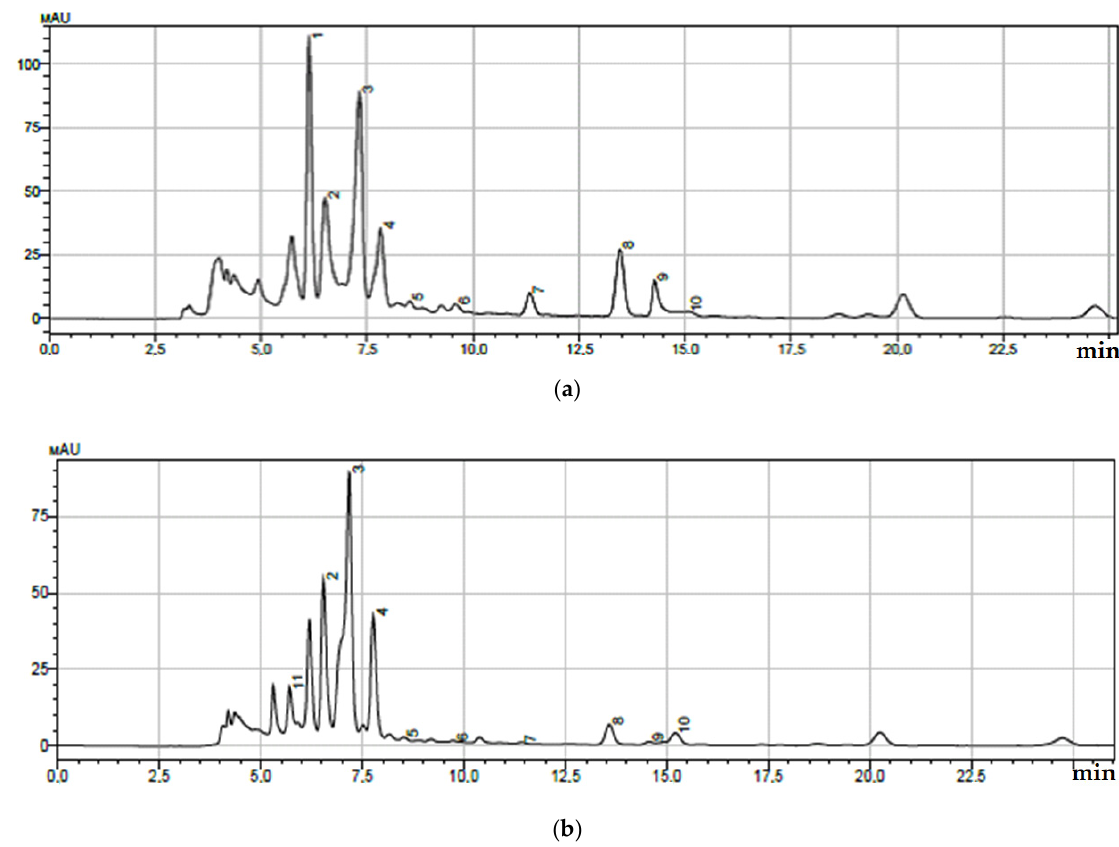
Figure 2. HPLC chromatogram of the Symphytum officinale extract samples containing ( a ) type I and ( b ) type II of the recovered polymer: peak 1–m-methoxybenzoic acid; 2–5-caffeoylquinic acid; 3–caffeic acid; 4–3-caffeoylquinic acid; 5–